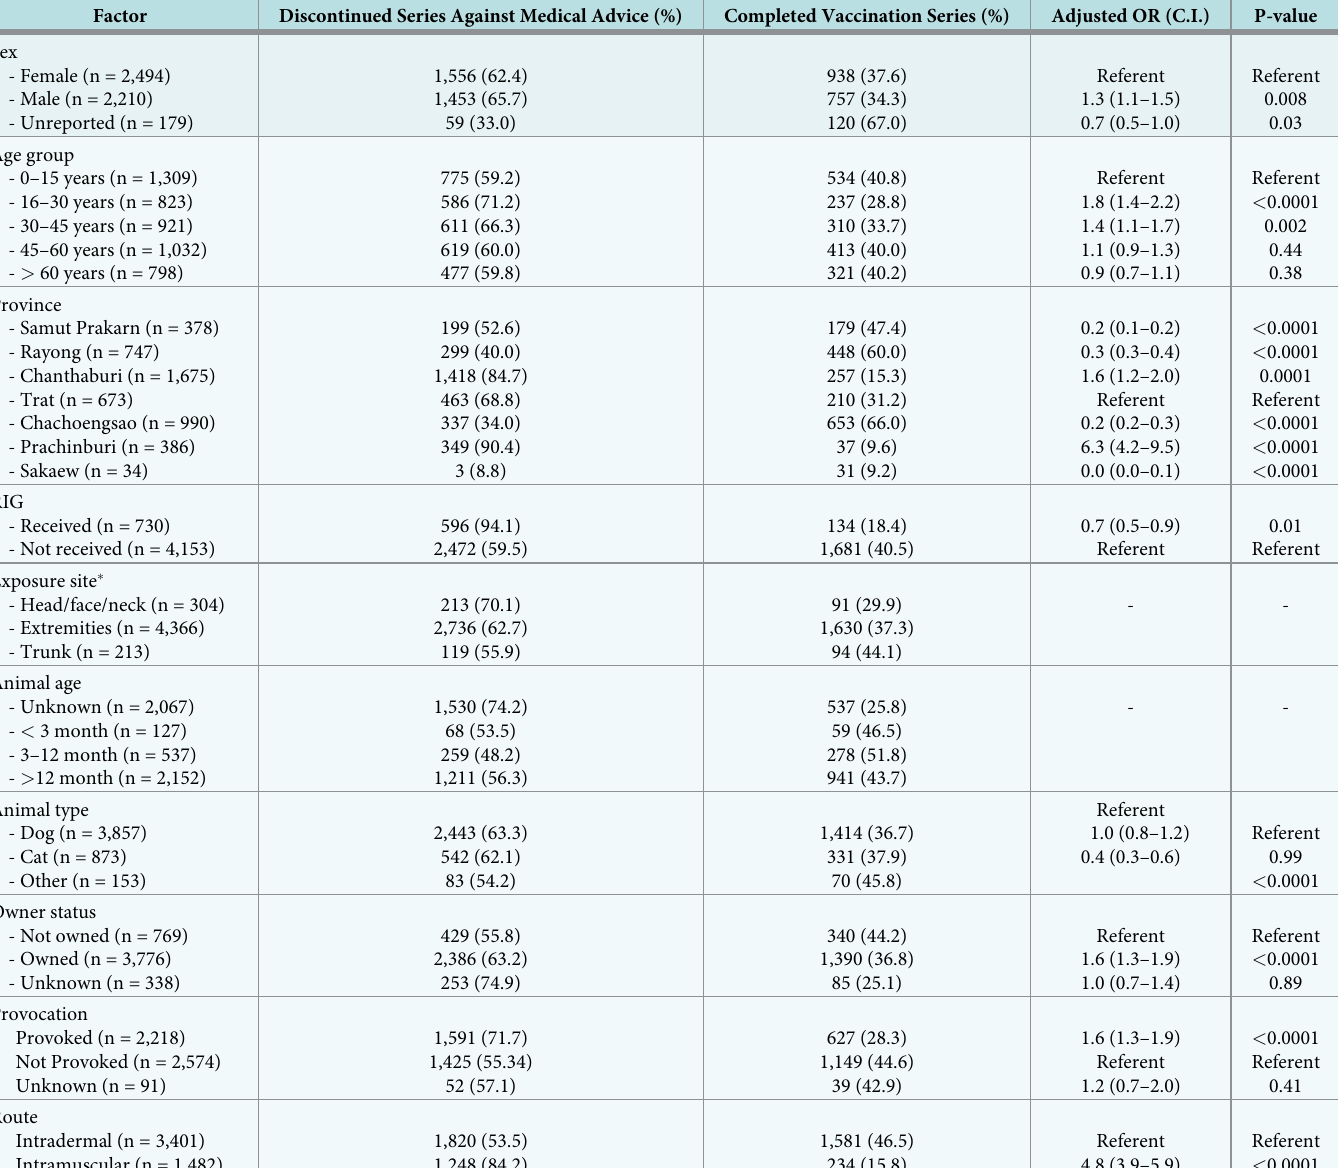
Table 6. Factors associated with PEP completeness in category III exposure that required 4 (intradermal) or 5 (intramuscular) doses of PEP, 1 st Jan– 31 st Dec 2015.